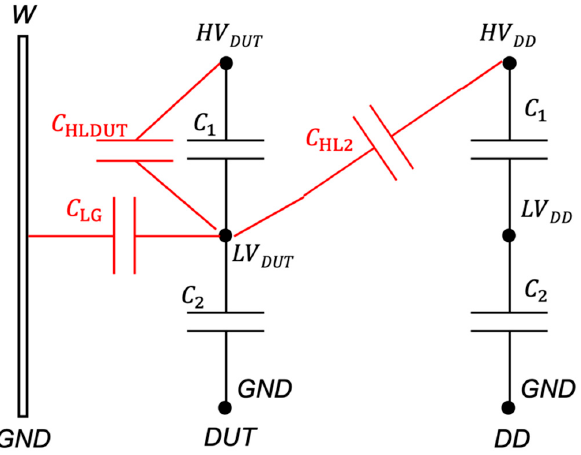
Figure 8. The final equivalent circuit of the setup in Figure 2 including the significant SCs.